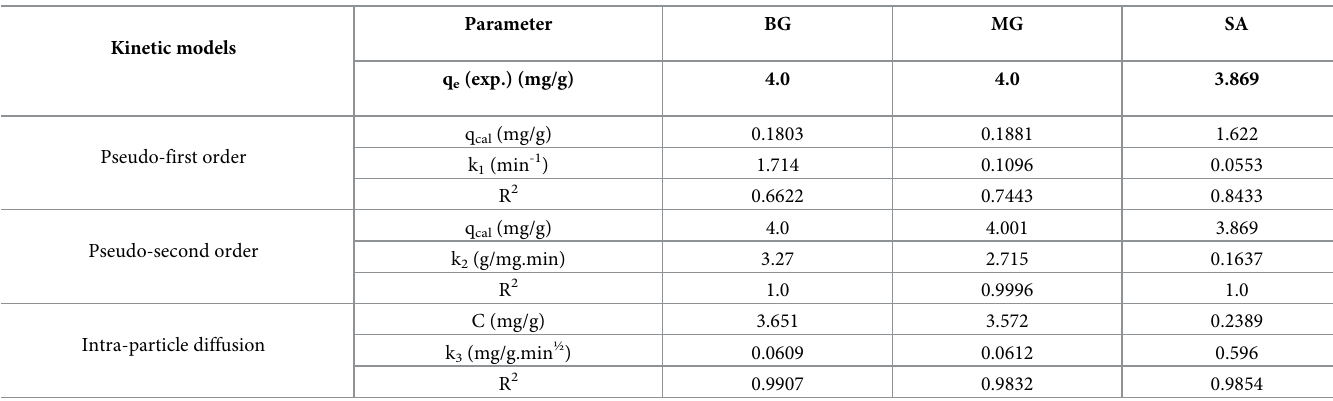
Table 1. Kinetic characteristics for the adsorption of BG, MG, and SA. Kinetic